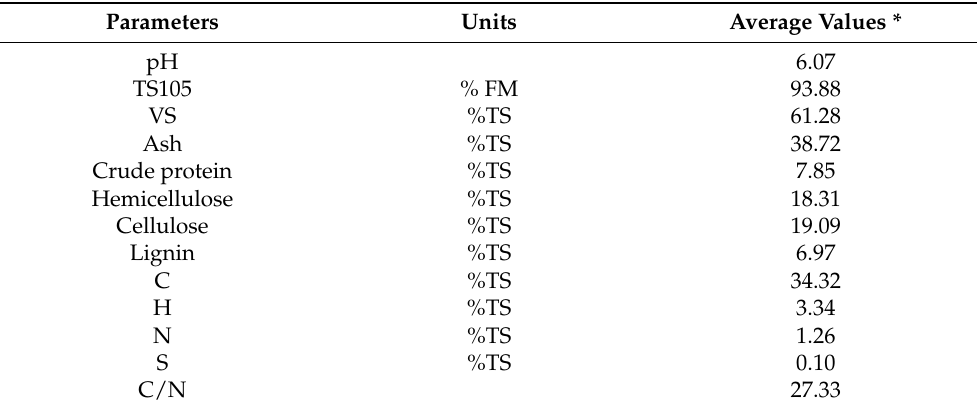
Table 1. Physical and chemical properties of the rice processing